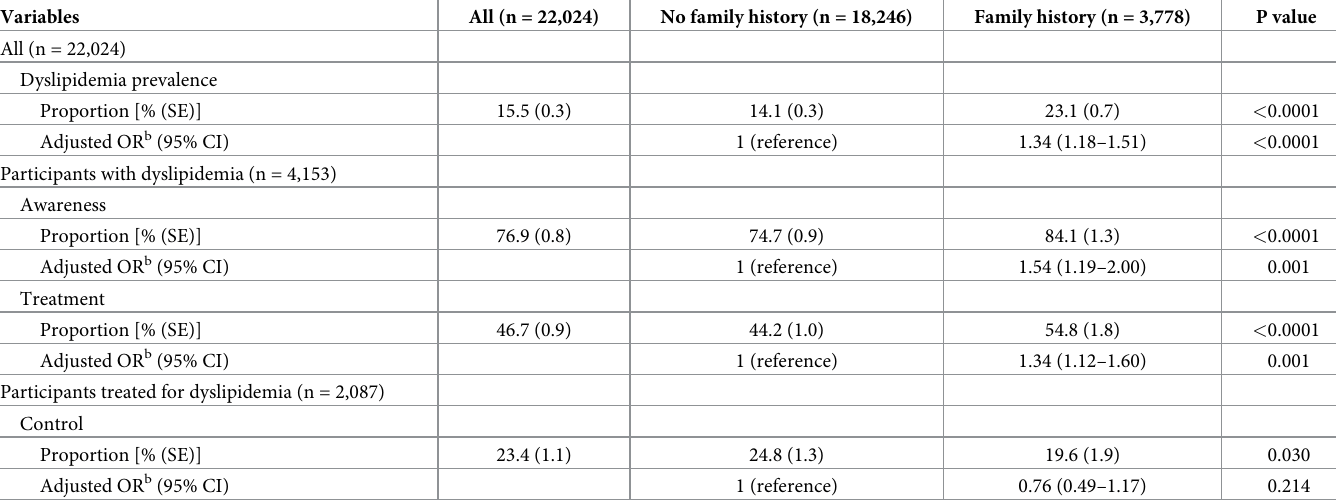
control rates of dyslipidemia The awareness and treatment rates of dyslipidemia were 76.9% and 46.7% respectively. In addition, the control rate among those treated for dyslipidemia was 23.4%. Dyslipidemia patients with an FH of CVD had significantly higher awareness (84.1% vs. 74.7%) and treat- ment (54.8% vs. 44.2%) rates than those without an FH of CVD. In terms of control of dyslipi- demia, the FH of CVD group had significantly lower rate than the non-FH group (19.6% vs 24.8%) (Table 2). The results of the multivariate logistic regression analysis for the prevalence, awareness, treatment, and control of dyslipidemia between those with and without an FH of Table 2. Association between family history of cardiovascular disease a and the prevalence, awareness, treatment and control of